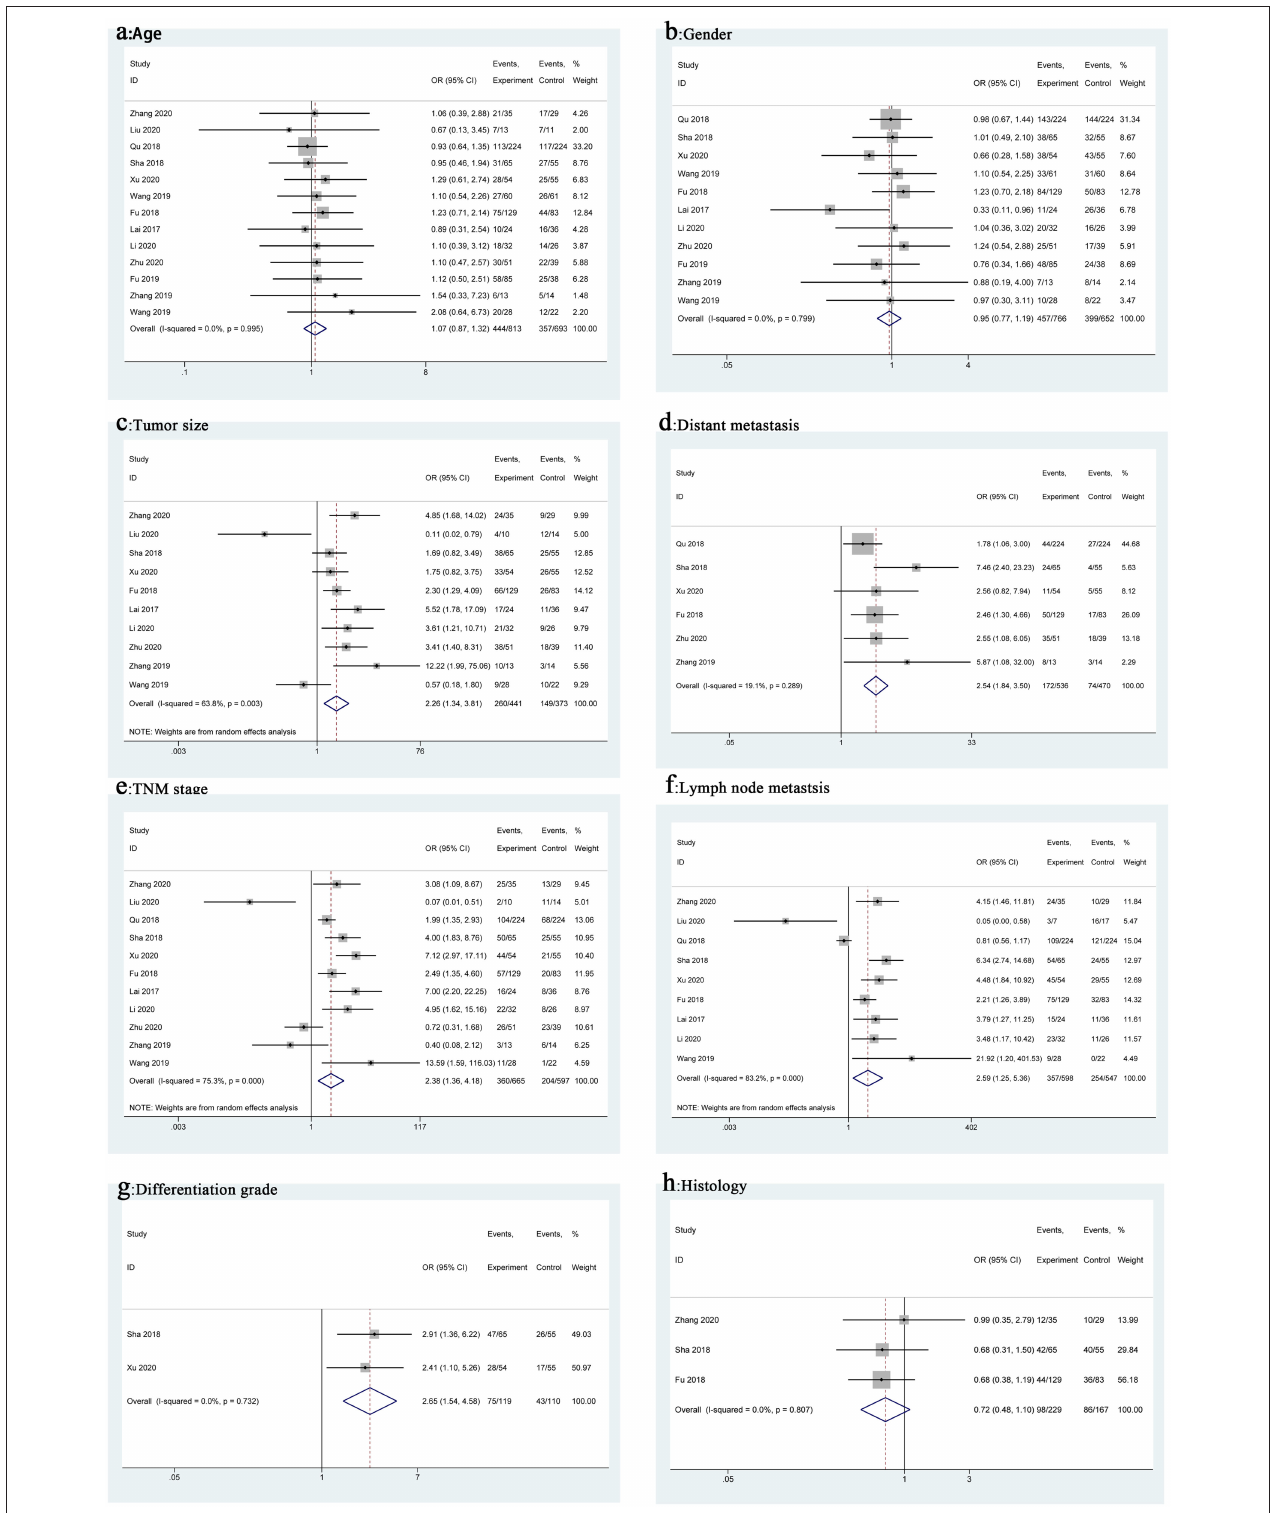
FIGURE 3 | Forest plots for association of MIAT expression with clinicopathological features: Age (a) , Gender (b) , Tumor size (c) , Distant metastasis (d) , TNM stage (e) , Lymph node metastasis (f) , Differentiation grade (g) , Histology (h) .